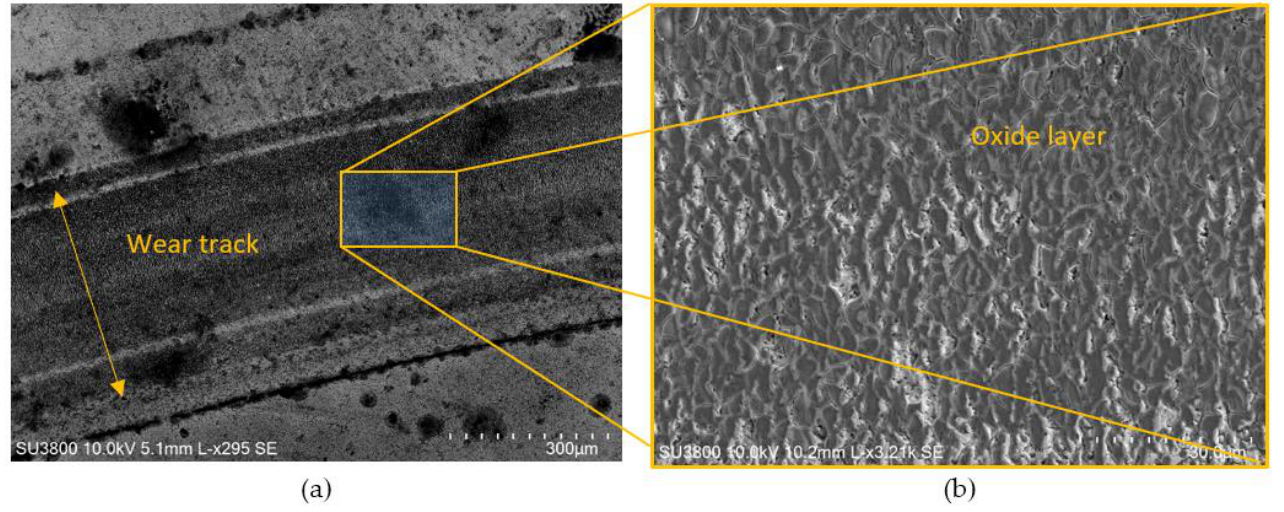
Figure 15. SEM micrographs of the wear track for the system WC-Co/Al 2 O 3 according to a magnifi- cation of: ( a ) 925× and, ( b ), 3.21K×.